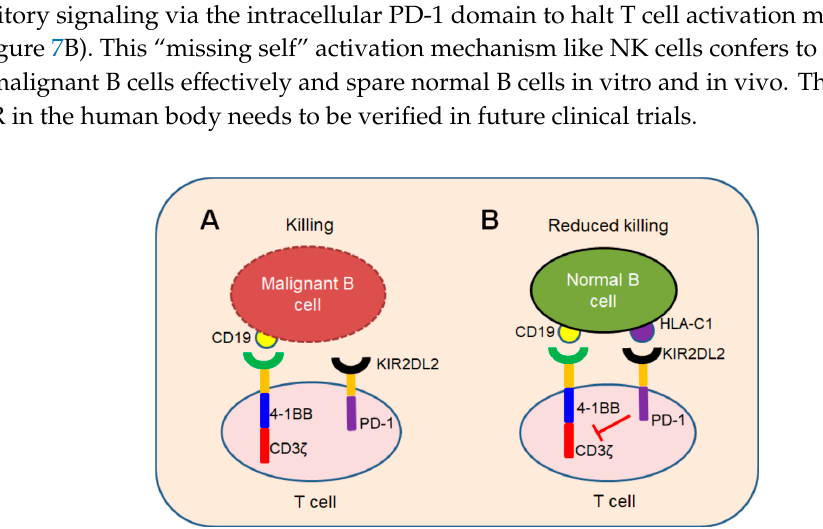
Figure 7. “Missing self” mechanism of iKP CAR. T cells co-expressing CD19 CAR and iKP CAR exploit “missing self” activation mechanism similar to NK cells. ( A ) T cells are activated by CD19 CAR and kill malignant B cells upon recognizing CD19 on malignant B cell tumors. ( B ) CD19 CAR activation signal is inhibited by PD-1 signal when iKP CAR is engaged to “self-HLA-C1” on normal B cells and iKP-19-CAR-T cells do not kill normal B cells.